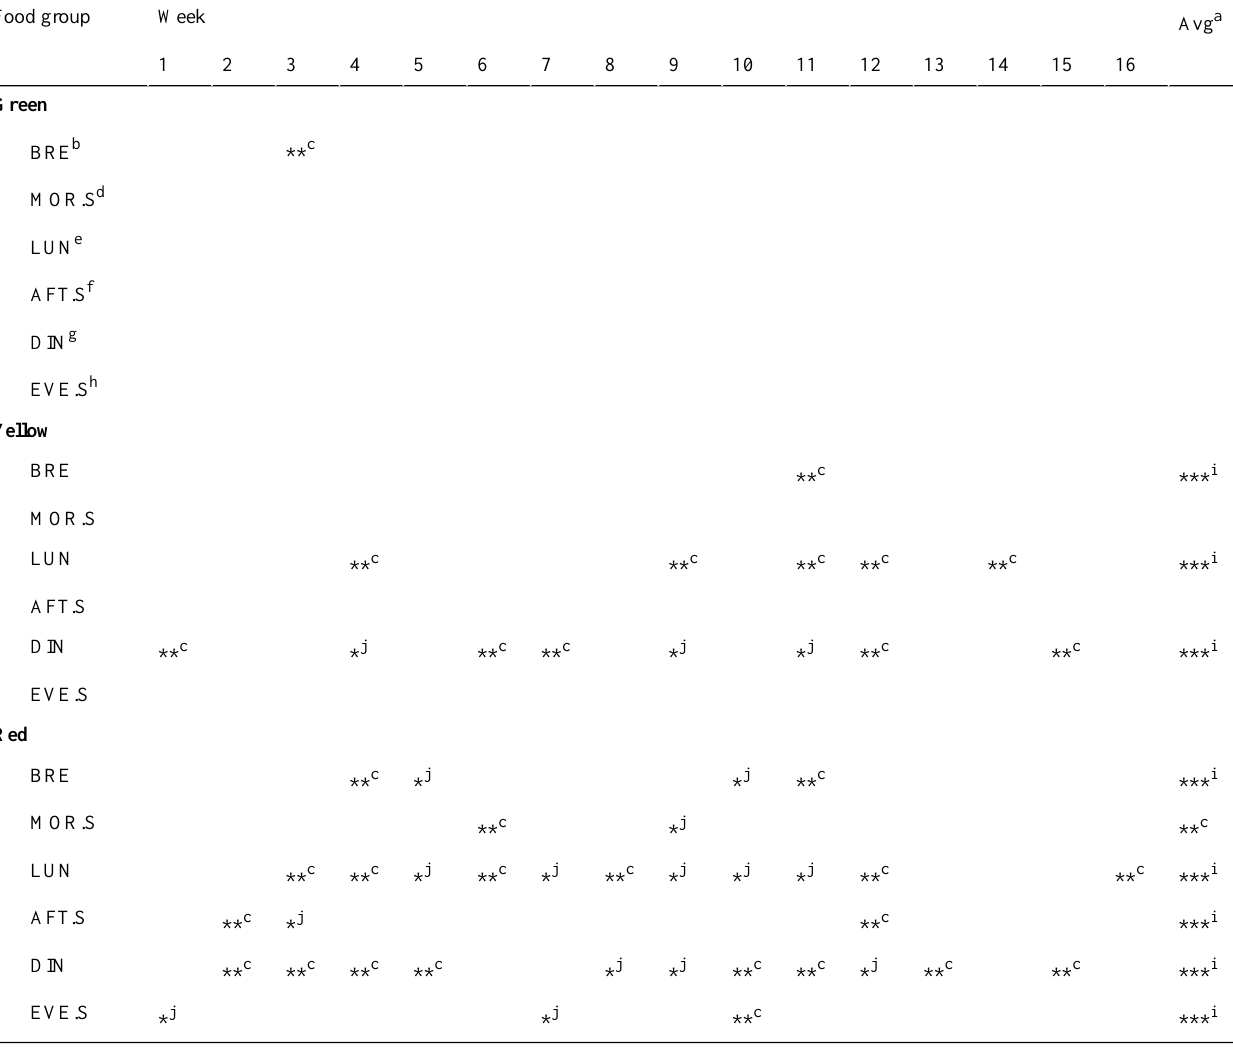
Table 3. Significance of analysis of variance (ANOVA) test results comparing the differences in intake amount by food group (green, yellow, and red) in women for 16 weeks. P values were adjusted with the false discovery rate using the Benjamini-Hochberg method, and the actual P values are available in Multimedia Appendix